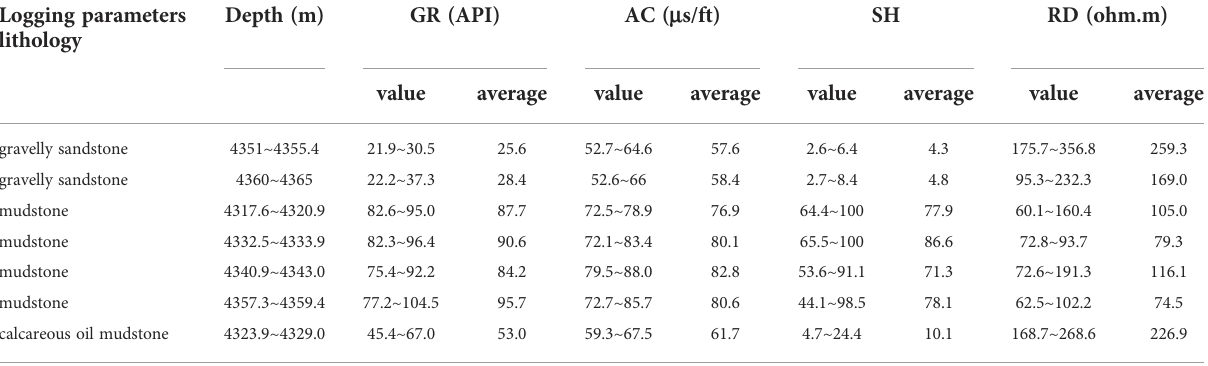
TABLE 2 Lithology and electricity comparison data of the lower Sha 3 subsection of Well Che